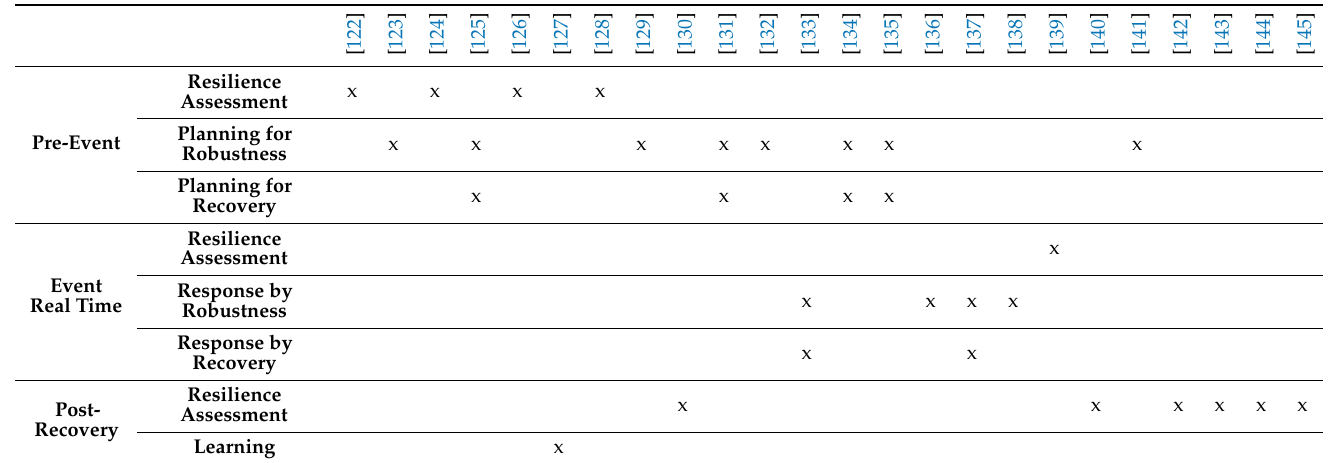
Table 2. Objective and time of evaluation for